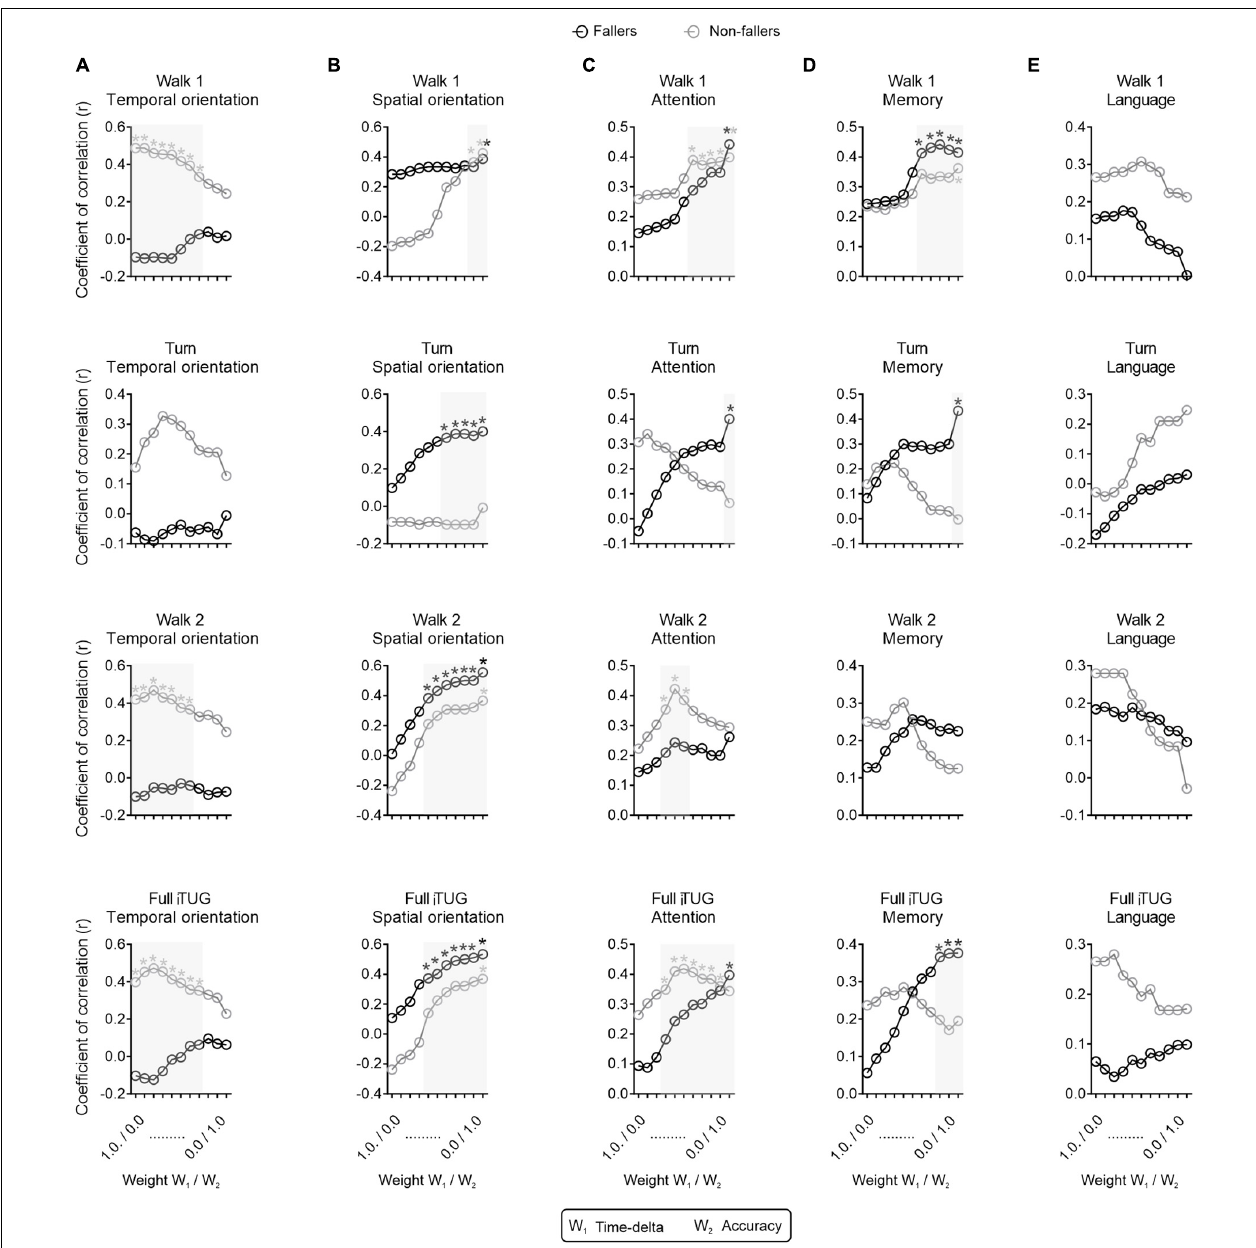
FIGURE 3 | Correlations between the novel P-index and mini-mental state examination (MMSE) domains. Correlation between the novel P-index and the (A) temporal orientation, (B) spatial orientation, (C) attention, (D) memory, and (E) language domains of the MMSE. * p < 0.05, r ,Spearman’s rank correlation